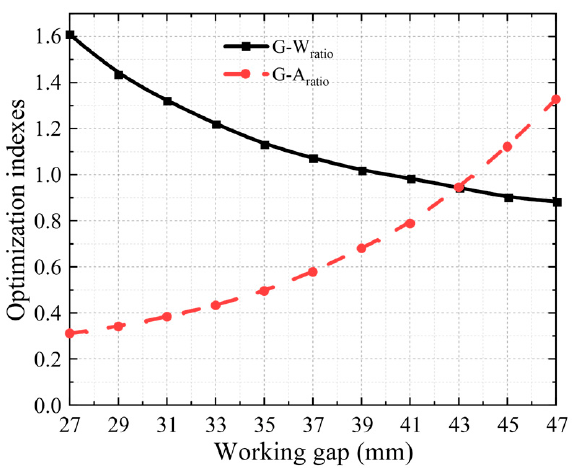
Figure 15. The optimization indexes as functions of working gap at the width is 6 mm and the thickness is 4 mm.